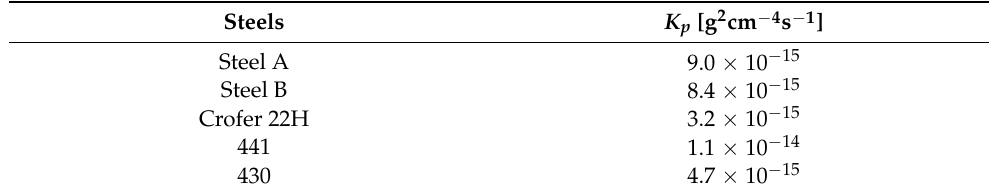
Table 2. Comparison among the parabolic oxidation rate constant ( K p ) of Steel A, Steel B, and those found in literature for Crofer 22H, 441, and 430 FSSs [45]. All were derived from weight gain measurements during oxidation in air at 750 °C.